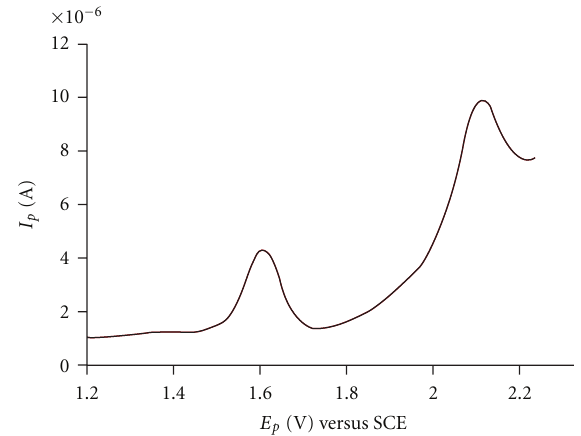
Figure 5: Di ff erential pulse voltammogram of aclonifen. ( C = 15ppm) and bifenox ( C = 15 ppm). Acetonitrile, Bu 4 NBF 4 (0.1M), glassy carbon ( d = 3mm); scan rate: 5 mVs − 1 ; pulse amplitude = 50mV; pulse width: 20ms.